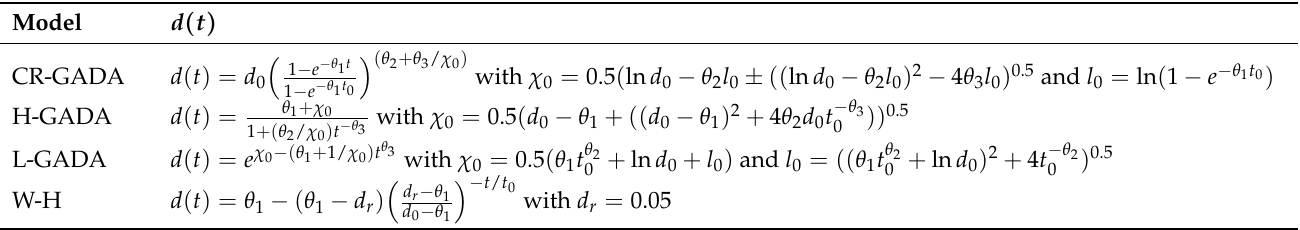
Table 2. GADA and hybrid equations, where d 0 is the diameter (cm) at site-index age t 0 (years); d r is the recruitment diameter at the time t = 0, which has been considered the same for all individuals; χ 0 is a site-specific parameter and θ i is the parameter associated for each